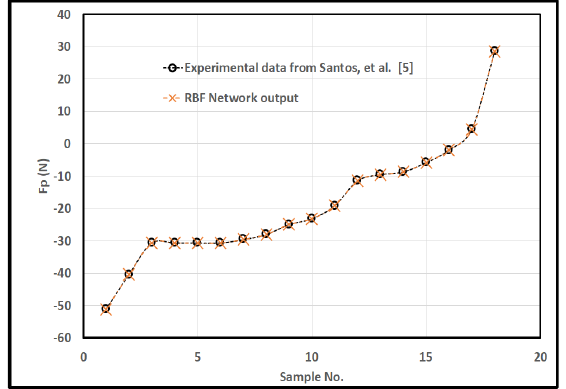
response against & (